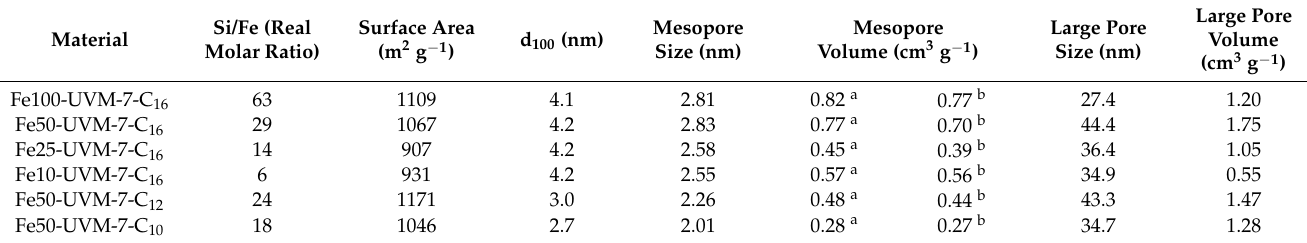
Table 1. Selected parameters of the synthesized mesoporous silica